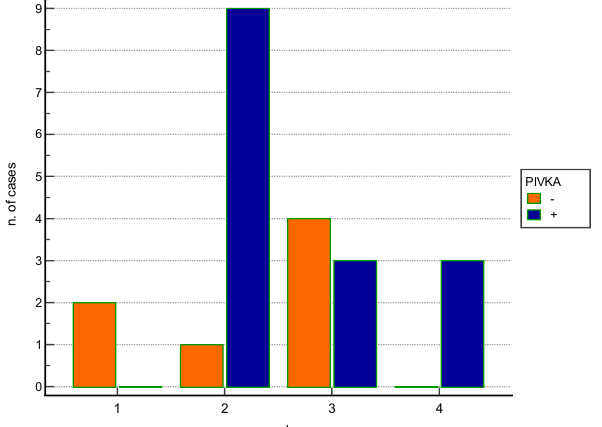
Figure 2. Histogram shows the distribution of positive and negative cases for PIVKA-II in relation to WHO histologic grade.